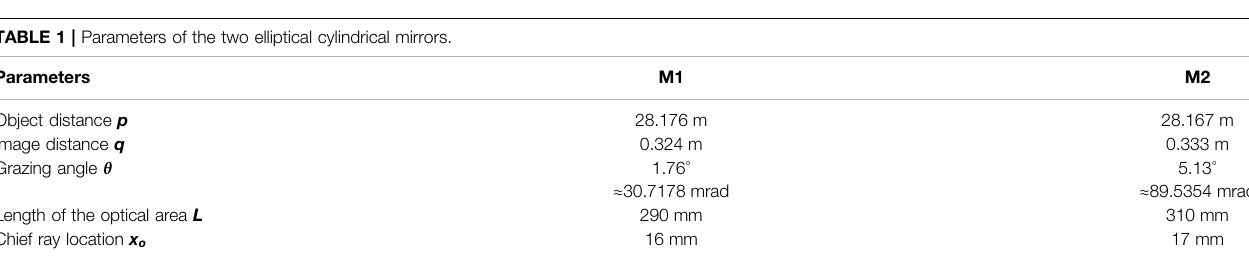
TABLE 1 | Parameters of the two elliptical cylindrical mirrors.